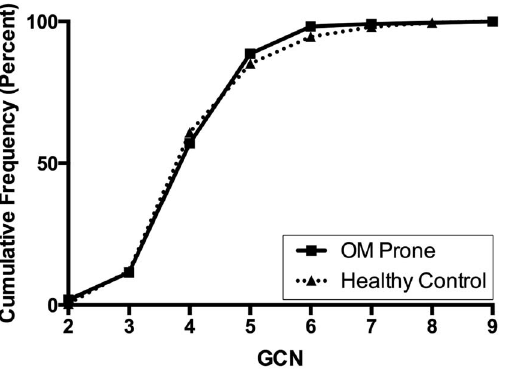
Figure 2. Cumulative DEFB-CN frequency (percent) distribution among OM prone and control subjects. The overall distribution of DEFB-CN did not differ significantly among OM prone (— && —) or control ( NNN m NNN ) study subjects (p .